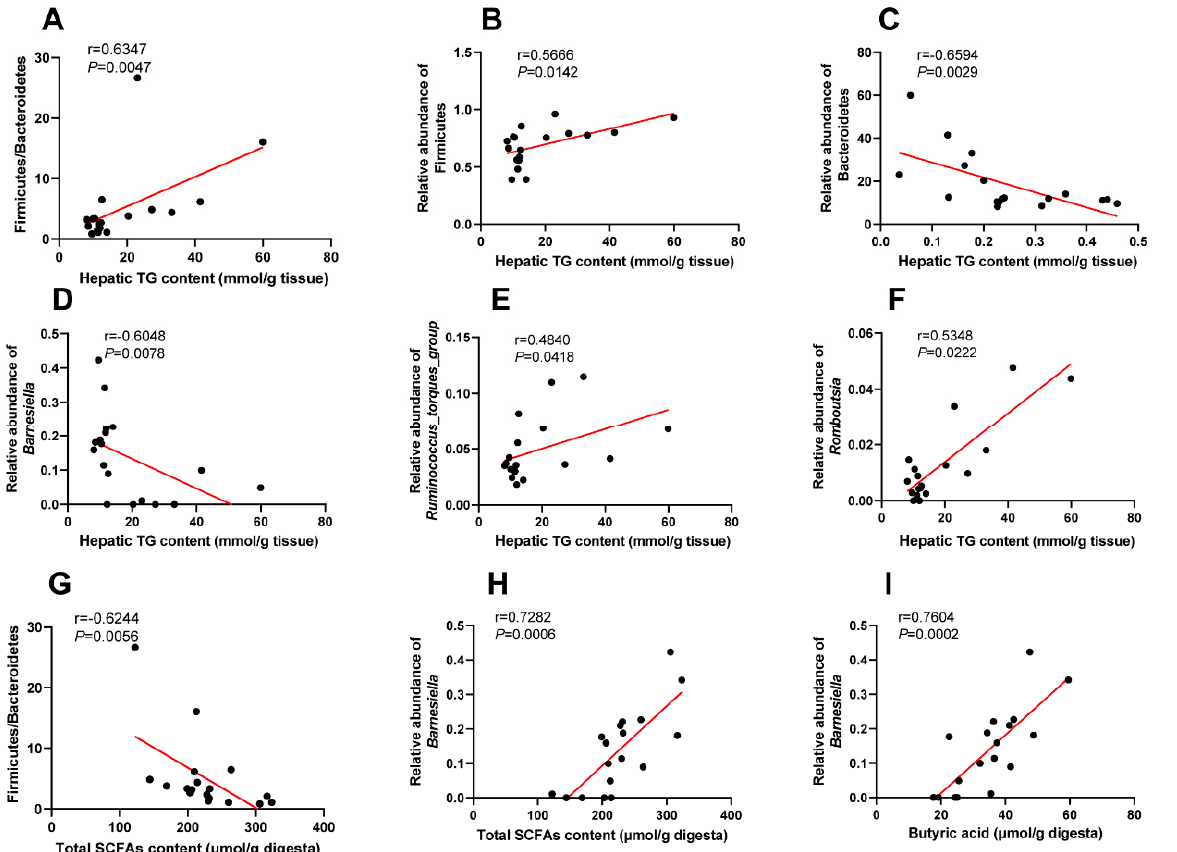
Figure 7. ( A ) the correlation between hepatic TG content and the ratio of Firmicutes/Bacteriodetes; ( B ) the correlation between hepatic TG content and the relative abundance of Firmicutes; ( C ) the correlation between hepatic TG content and the relative abundance of Bacteriodetes; ( D ) the correlation between hepatic TG content and the relative abundance of Barnesiella ; ( E ) the correlation between hepatic TG content and the relative abundance of Ruminococcus_torques_group ; ( F ) the correlation between hepatic TG content and the relative abundance of Romboutsia ; ( G ) the correlation between cecal SCFAs and the ratio of Firmicutes/Bacteriodetes; ( H ) the correlation between cecal SCFAs and the relative abundance of Barnesiella ; ( I ) the correlation between cecal butyric acid and the relative abundance of Barnesiella .